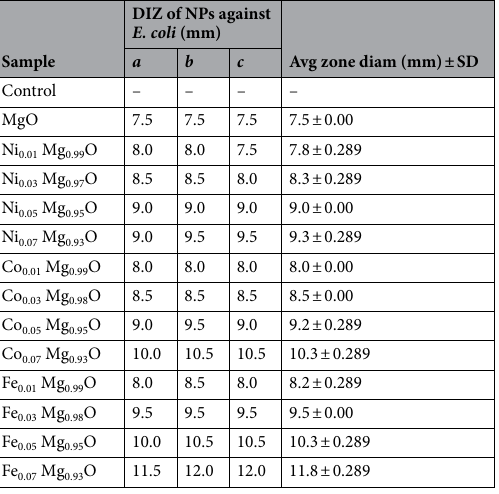
Table 4. The average diameter of inhibition zone of Ni, Co, and Fe-doped MgO nanoparticles at 40 μg/ml against E. coli.